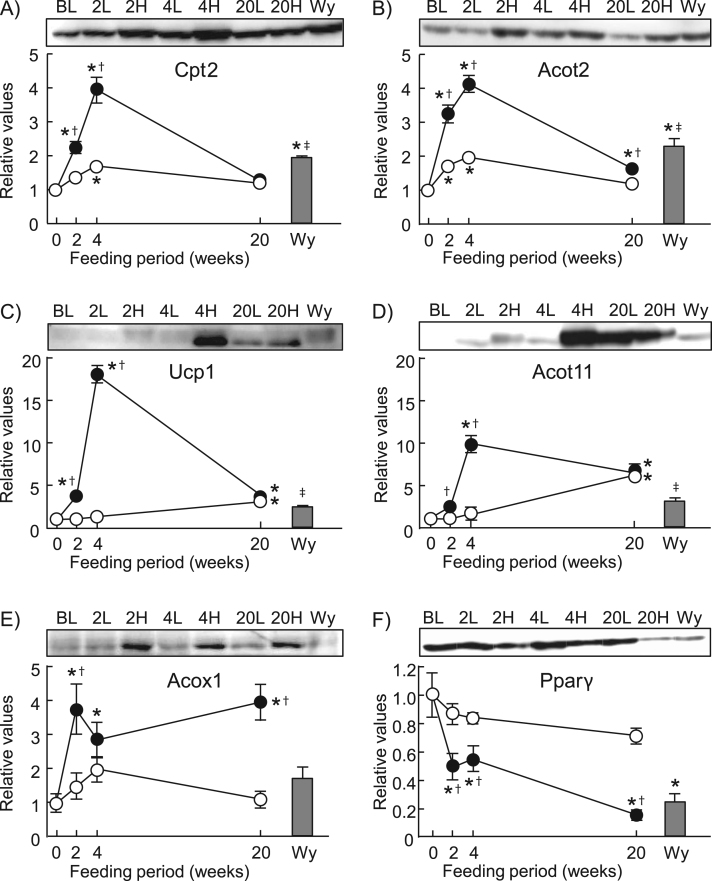
Changes in expression levels of Cpt2 (A), Acot2 (B), Ucp1 (C), Acot11 (D), Acox1 (E) and Pparγ (F) in BAT of mice after long-term HFD-feeding. After 1 week of acclimatization [baseline (BL)], C57BL/6J mice were fed a LFD (open circles) or HFD (closed circles) for up to 20 weeks. A group of mice were treated with Wy-14,643 for 2 weeks (Wy) (shaded columns), being maintained on the LFD. The expression levels of the proteins (A–F) were analyzed by western blotting with BAT homogenates. Signal intensities of the protein bands (per mg protein) were measured and are expressed relative to the baseline values, which were set as 1 (mean±SEM of 5–8 mice). *p<0.05 vs. BL; †p<0.05 vs. the LFD group at the same feeding time period; ‡p<0.05 between Wy group and HFD group at 4 week-feeding. Representative western blots (20 µg protein/lane) are also shown for Cpt2 (65 kDa), Acot2 (45 kDa), Ucp1 (30 kDa), Acot11 (65 kDa), Acox1 (52 kDa subunit) and Pparγ (52 kDa) in BAT of mice fed LFD for 2, 4 or 20 weeks (2 L, 4 L and 20 L, respectively), or HFD for 2, 4 or 20 weeks (2 H, 4 H and 20 H, respectively). The data shown in Fig. 1 for Cpt2, Acot2, Ucp1 and Acot11 of C57BL/6J mice are plotted as the corresponding values in A–D, respectively.